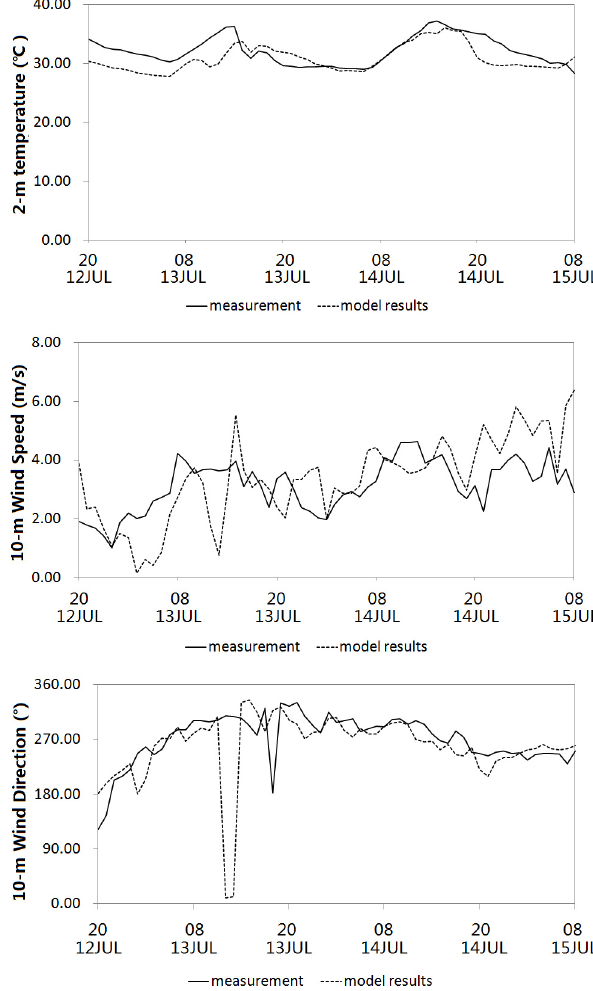
Fig. 5. Observed and simulated 2m temperature, wind speed, and wind direction at Guangzhou station on 12–15 July